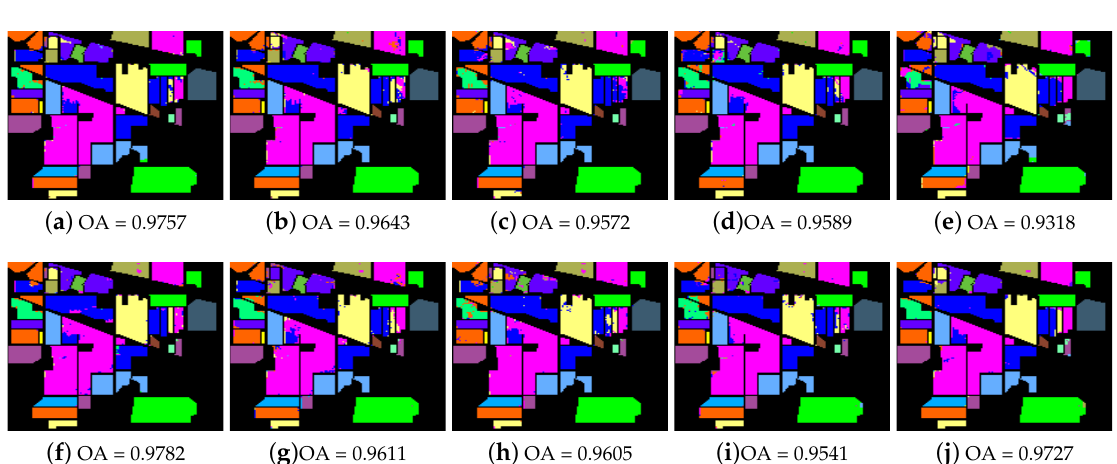
Figure 6. Supervised and semi-supervised classification results (Indian Pines image) obtained